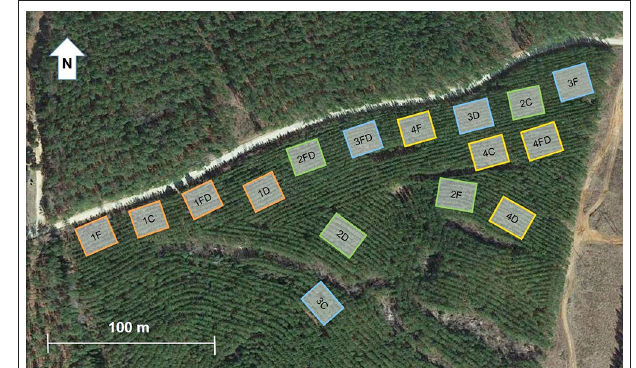
FIGURE 2 | Map of experimental treatments and blocks located in Taliaferro County, Georgia. Four treatments were randomly assigned in each of the four blocks: control (C), fertilization (F), throughfall reduction (D) and combined treatment of FD. Fertilizer additions included N, P, K and micronutrients and throughfall reduction diverted 30% of throughfall off of the plot. Blocks were established by grouping plots with similar tree height (6.34 ± 0.58m average at time of treatment initiation in 2012) and basal area (8.79 ± 1.58 m 2 /ha average at time of treatment initiation).